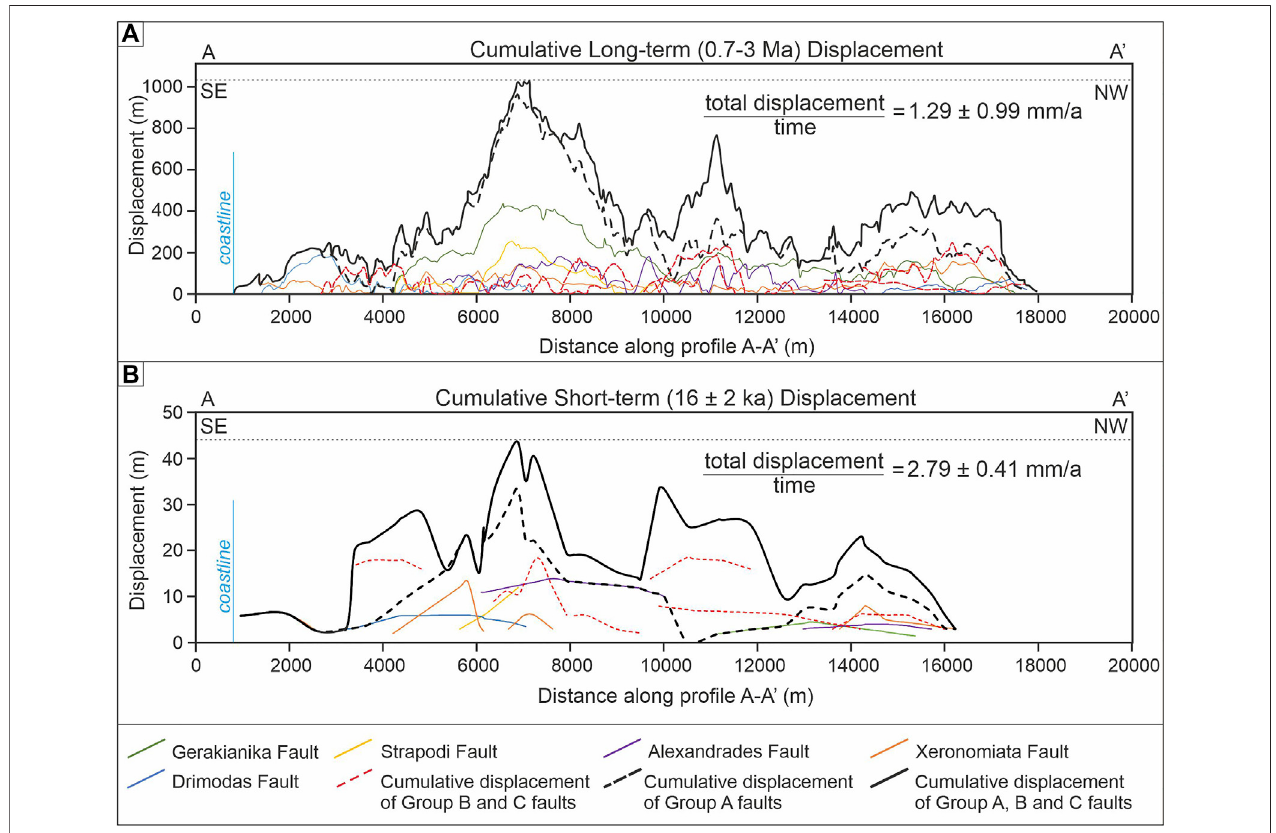
FIGURE 10 | Plots illustrating the aggregated 0.7 – 3 Ma (A) and 16 ± 2 ka (B) displacement distribution along the pro fi le A-A ’ (see Figure 2A for location) for the faults in Kythira. The bold dashed line indicates the aggregated displacement accumulated by Group A faults alone. The bold black line indicates the total displacement accrued by all faults on the island of Kythira, while the grey dotted horizontal line on each graph, indicates the maximum cumulative displacement.